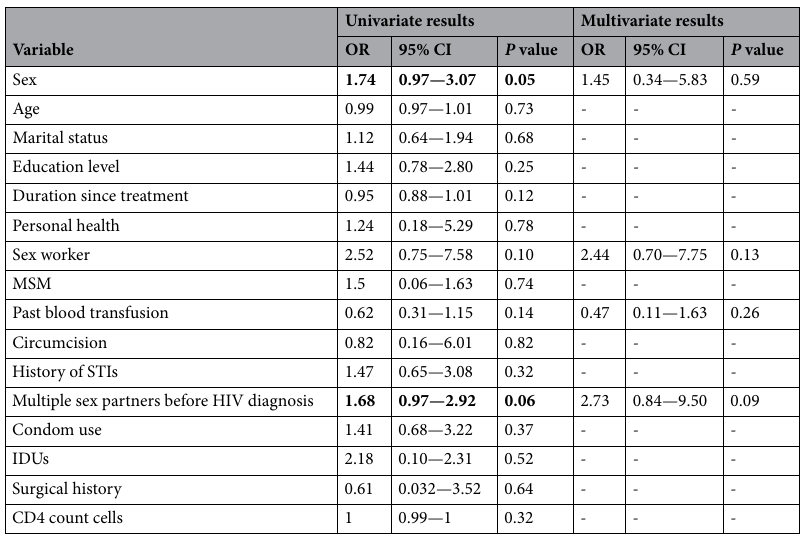
Table 4. Risk factors associated with HHV-8 seropositivity. Significant results are given in bold. OR: odd ratio; CI: confidence interval; MSM: men who have sex with men; IDUs: intravenous drug users; STI: sexually transmitted